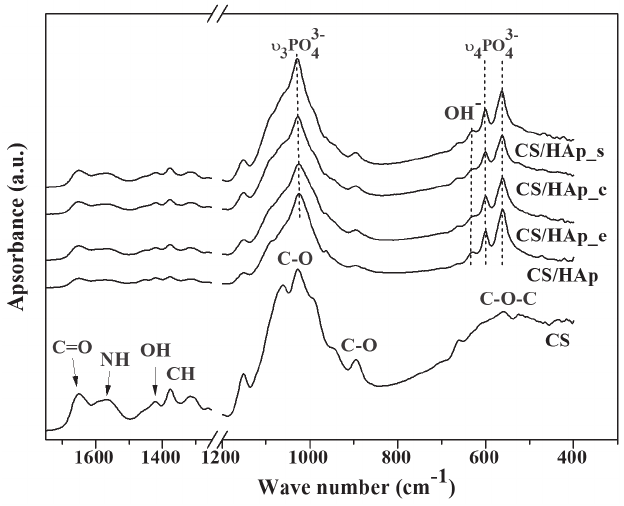
Fig. 6 – FTIR spectra of prepared composite scaffolds ob- tained from different biogenic sources. Chitosan (CS) scaffold was used as a control.